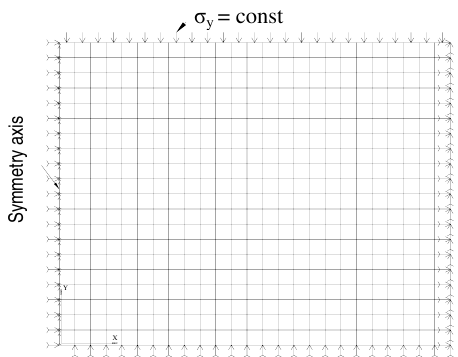
Fig 2 . Finite elements representation of the oedometer sample